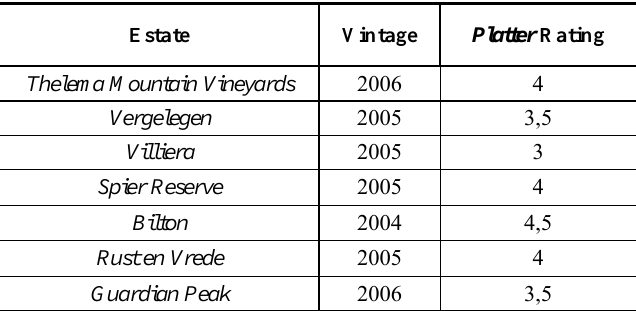
Table 1: The seven wines tasted by all 32